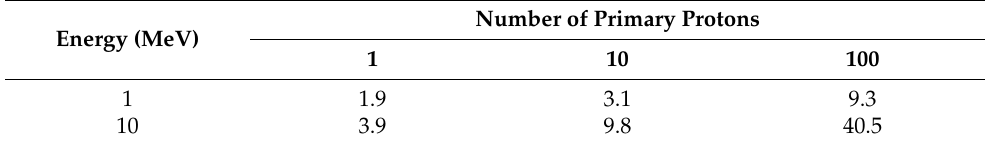
Table 5. The simulation time (s) of physically transporting 1, 10, and 100 protons for proton energies at 1 and 10 MeV by gMicroMC on a single GPU